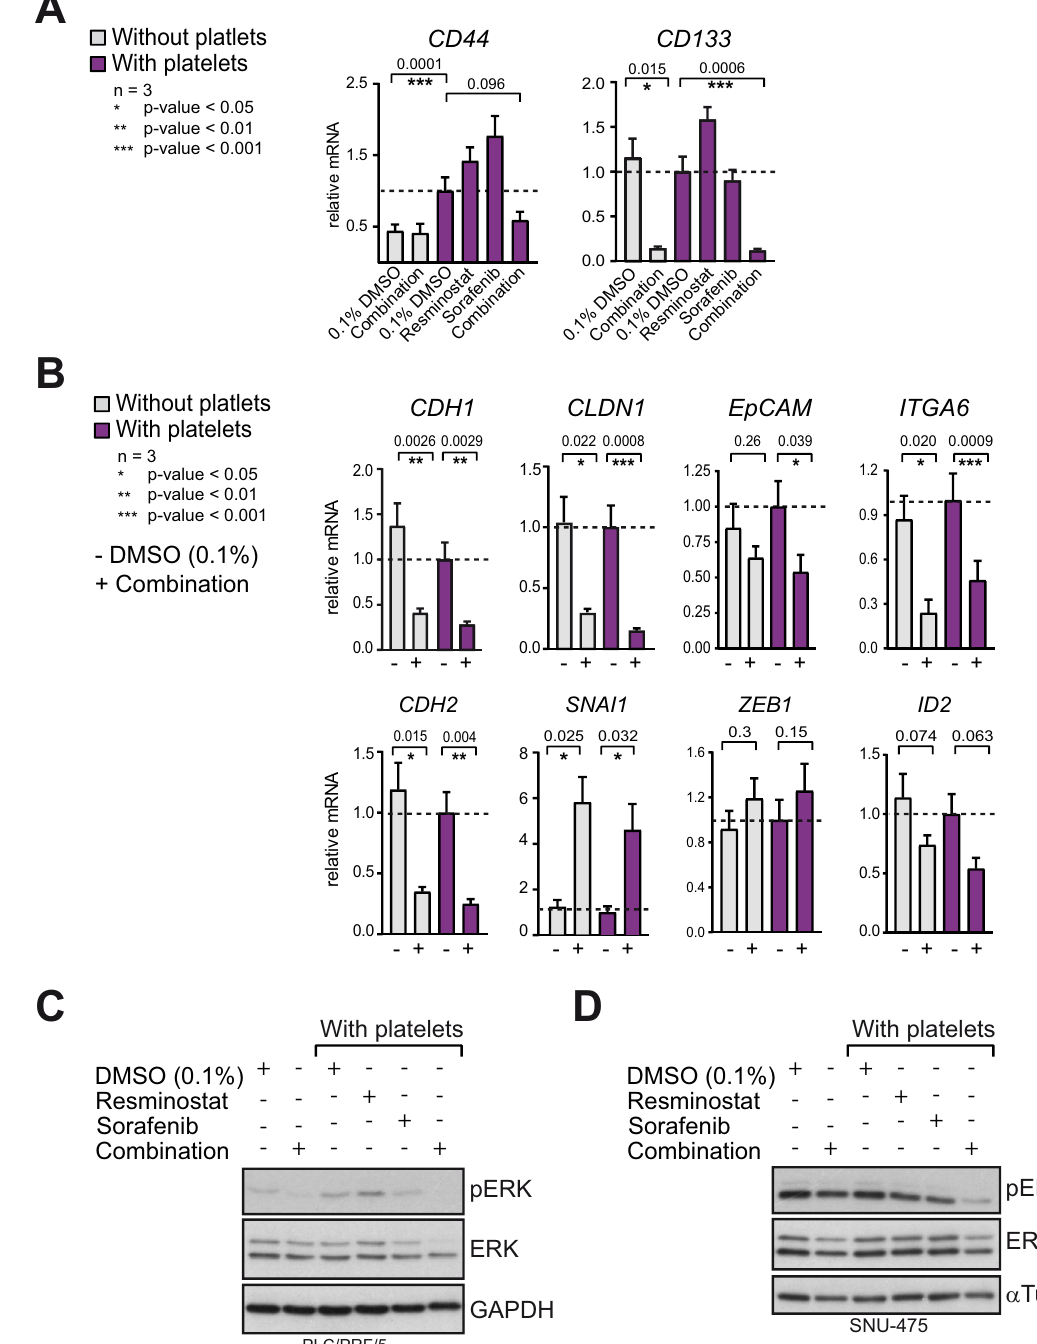
Figure 5. The combination of resminostat and sorafenib de-regulates the expression of EMT genes and decreases pERK level. ( A ) Relative mRNA expression of mesenchymal and cancer stem cell marker CD44 and CD133 . PLT/PRF/5 cells were treated with or without platelets and with drug(s) as indicated. Data from three biological replicates are presented as data means with SD. Paired two-tailed t-test was performed. ( B ) Relative mRNA expression of EMT genes CDH2 ( N-Cadherin ), SNAI1 , ZEB1 , ID2, CDH1 ( E-Cadherin ), CLDN1, EpCAM and ITGA6 . Data from three biological replicates are presented as data means with SD. Paired two- tailed t-test was performed. ( C ) Western blots for total level of the MEK signaling kinase ERK and its activated form pERK (phosphorylated ERK). GAPDH was used as loading control. PLC/PRF/5 cells were cultured with or without platelets and with drugs as indicated. Grouped blots were composed from cropped parts of individual blots for each antibody. Original blots with exposures and indicated cropped areas can be found in the supplementary information. ( D ) Same as in ( C ) but with SNU-475 cells. Staining for α-Tubulin was used as loading